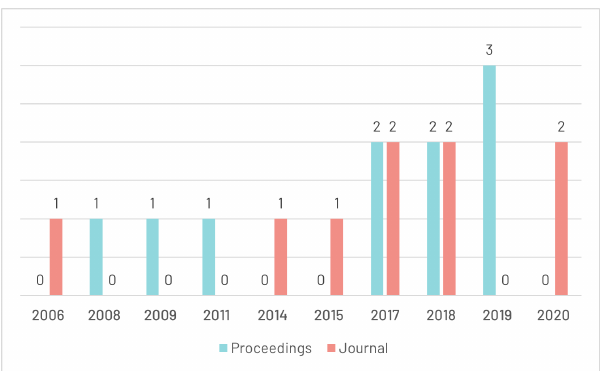
Figure 6. Studies per year and type of publication